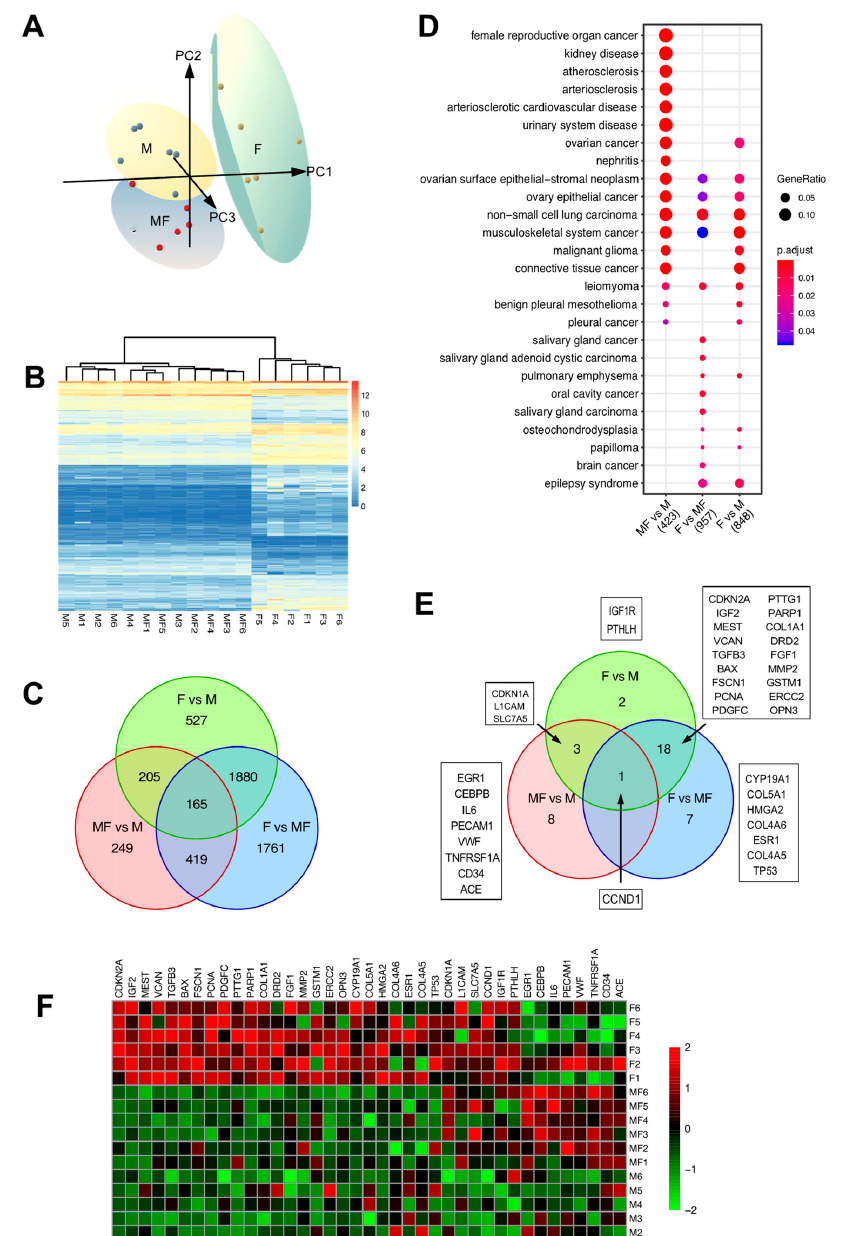
Figure 4. Transcriptome characterization of all 3 groups: myometrium from non-fibroid patients (M), myometrium from fibroid patients (MF) and fibroids (F) ( A ) 3D Principal component analysis plot based on RNA-seq gene expression data. Ellipses represent 95% confidence in each group ( n = 6/group). Yellow, blue and green ellipses represent the group M, MF and F, respectively. Individual dots represent each sample analyzed. ( B ) Heatmap of the top 500 differentially expressed genes (DEGs)of M, MF, F groups with unsupervised hierarchical clustering of genes and samples ( n = 6/group). Color gradient represents gene expression levels as log 2 (CPM + 1). ( C ) Venn diagram illustrates the DEG overlapping between MF vs. M, F vs. MF, and F vs. M (5206 genes total). ( D ) Top overrepresented Disease Ontology terms for MF vs. M, F vs. MF, and F vs. M upregulated genes. Gene enrichment ratio and significance level are shown by the size and color of each circle, respectively. ( E ) Venn diagram leiomyoma disease ontology genes illustrates the overlap between MF vs. M, F vs. MF, and F vs. M (39 genes total). ( F ) Heatmap of the 39 leiomyoma enriched genes in MF vs. M, F vs. MF, and F vs. M ( n = 6/group). Color gradient represents gene expression levels as z-scores.